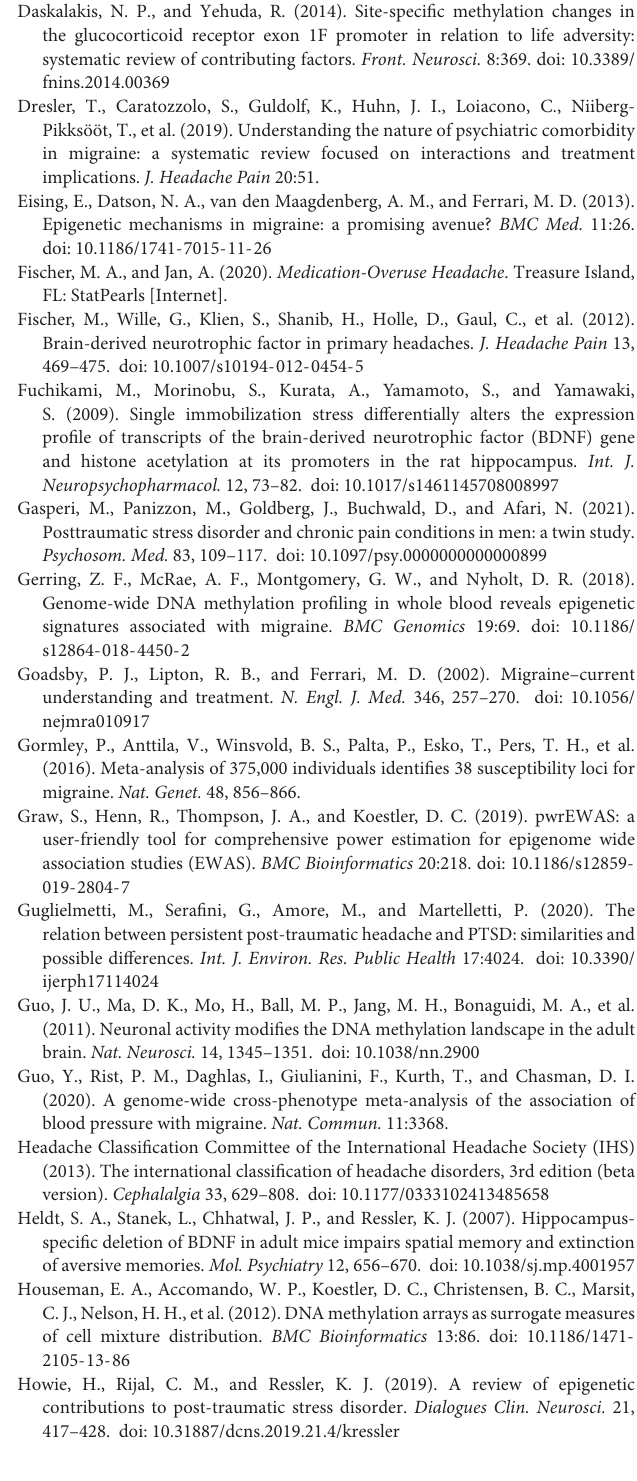
Supplementary Figure 1 | Correlation of DNA methylation in blood and brain for MEG8 gene. Supplementary Table 1 | A list of all PTSD Candidate genes tested in the MZ